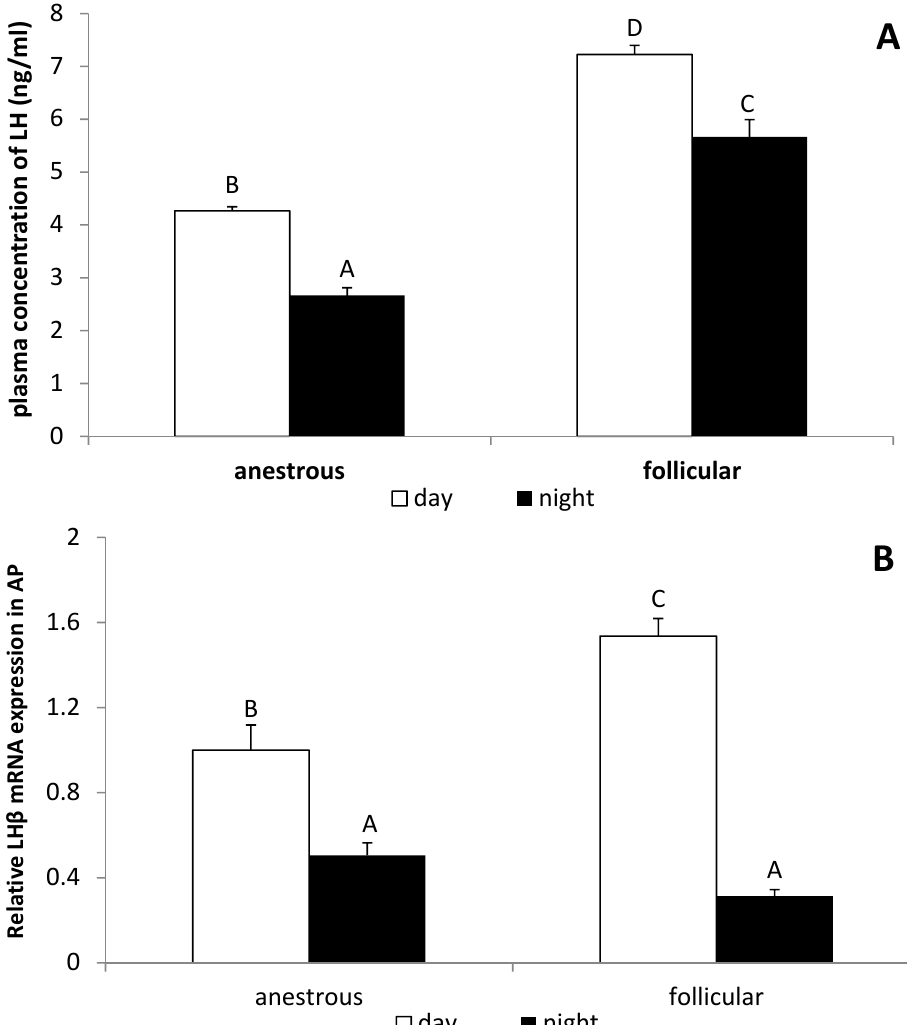
Figure 1. The day/night changes in the circulating level of luteinizing hormone (LH) ( A ) and gene expression of LH β ( B ) in the anterior pituitary (AP) in the anestrous and follicular phase ewes. Gene expression data were normalised to the average relative level of LH β gene expression measured in the anestrous animals from the day experiment, which was set to 1.0. All data are presented as the mean ( ± S.E.M.). Different capital letters indicate significant ( p < 0.05) differences according to a two-way ANOVA followed by NIR Fisher’s post-hoc test.